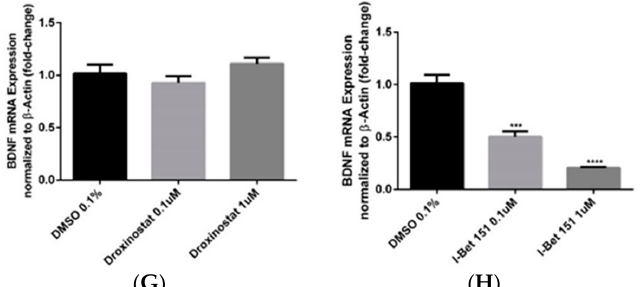
Figure 3. BDNF mRNA expression level in HEK293 cells upon treatment with various compounds as determined by RT-qPCR analysis. ( A – C ) JNJ-26481585, PCI-24781, and SB939 significantly increased the amount of BDNF mRNA expression. ( D ) Trichostatin A moderately increased the BDNF mRNA expression. ( E – G ) In case of ellagic acid, entacapone, and droxinostat, the level of BDNF mRNA was either not changed at all or the change was not significant. ( H , I ) Bet 151 was shown to be a negative control for BDNF mRNA expression, decreasing its amount significantly. Data were normalized to β -actin. Three biological replicates were used per treatment; Error bars represent SEM; ** p < 0.01, *** p < 0.001, **** p < 0.0001.